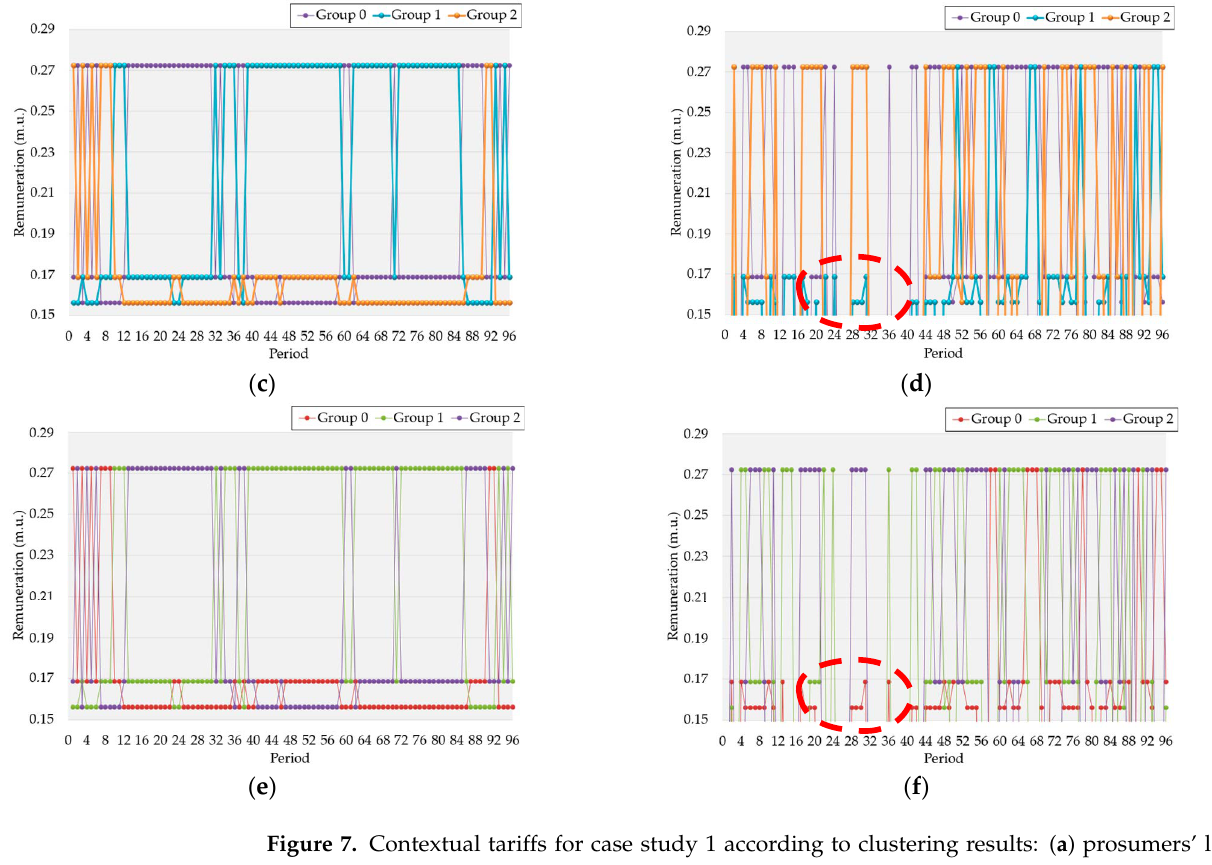
Table 6. Performance results from the classification methods.